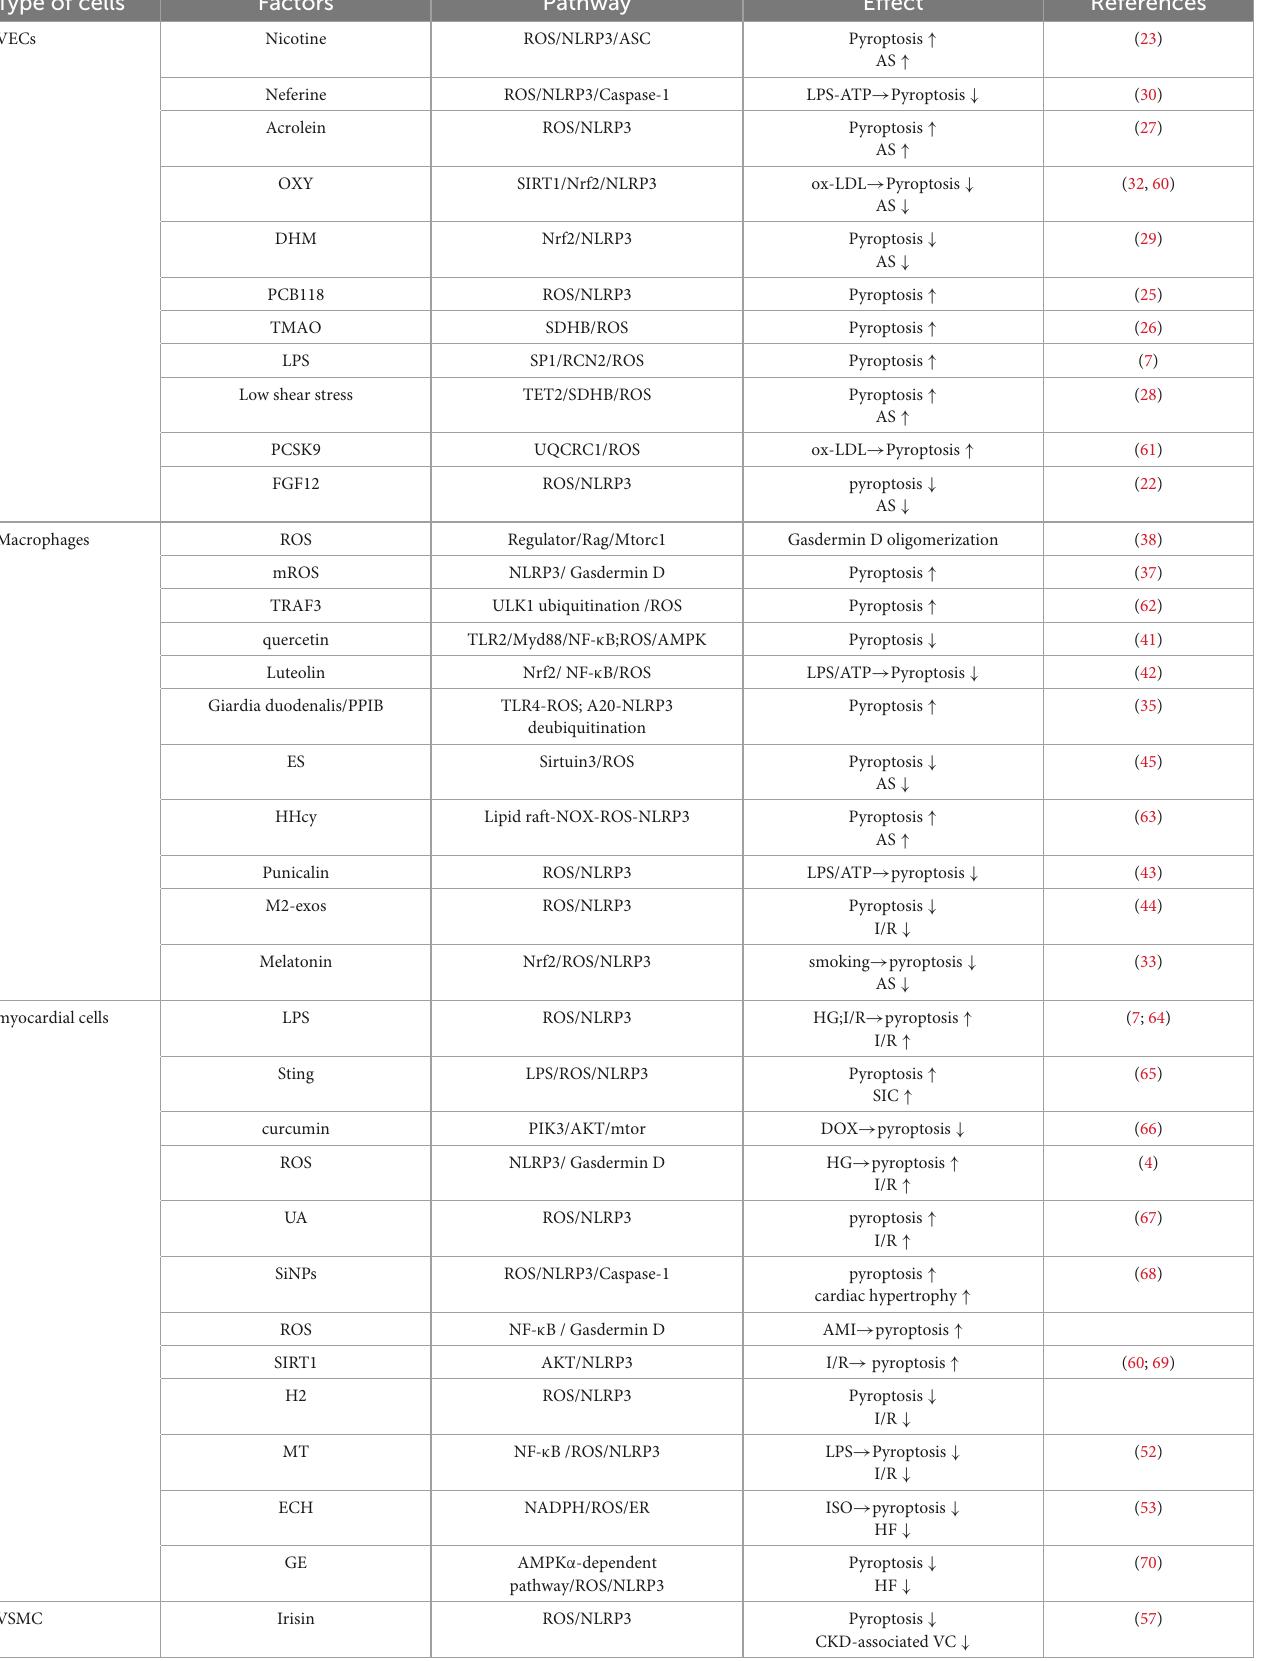
TABLE 1 The role of ROS-mediated pyroptosis in vascular endothelial cells, macrophages, cardiomyocytes and CVD. Type of